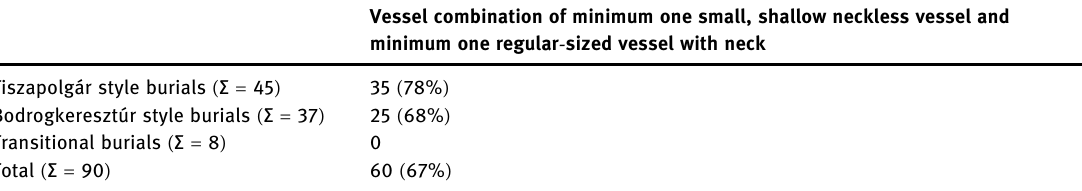
Table 2: The number of graves containing minimum one small, shallow neckless vessel and minimum one regular - sized vessel with neck at Tiszapolgár - Basatanya Vessel combination of minimum one small, shallow neckless vessel and